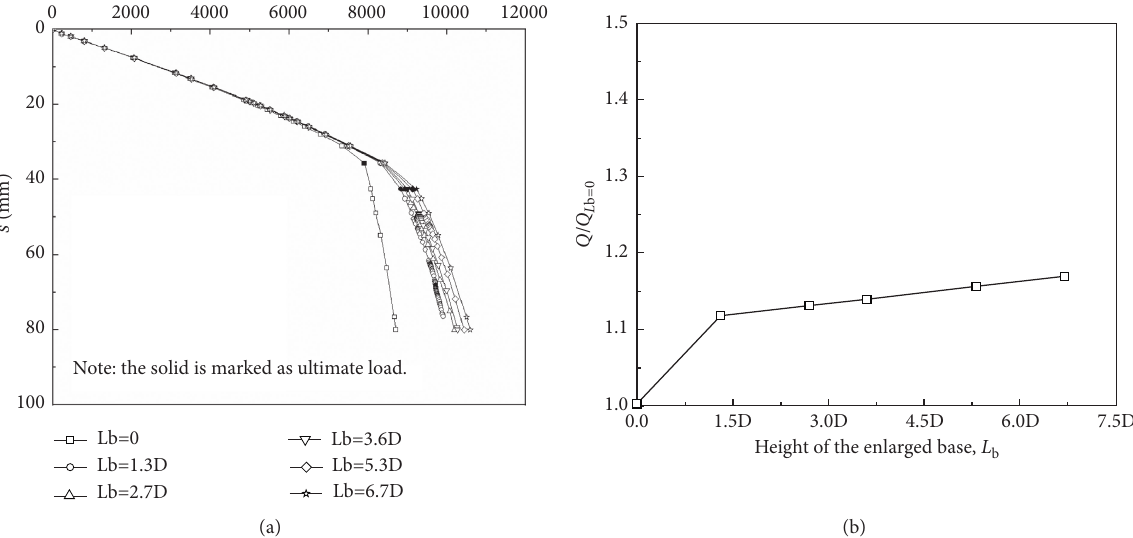
Figure 11: Influence of the height of the enlarged base on bearing capacity. (a) Q-s curves. (b) Comparison and analysis.